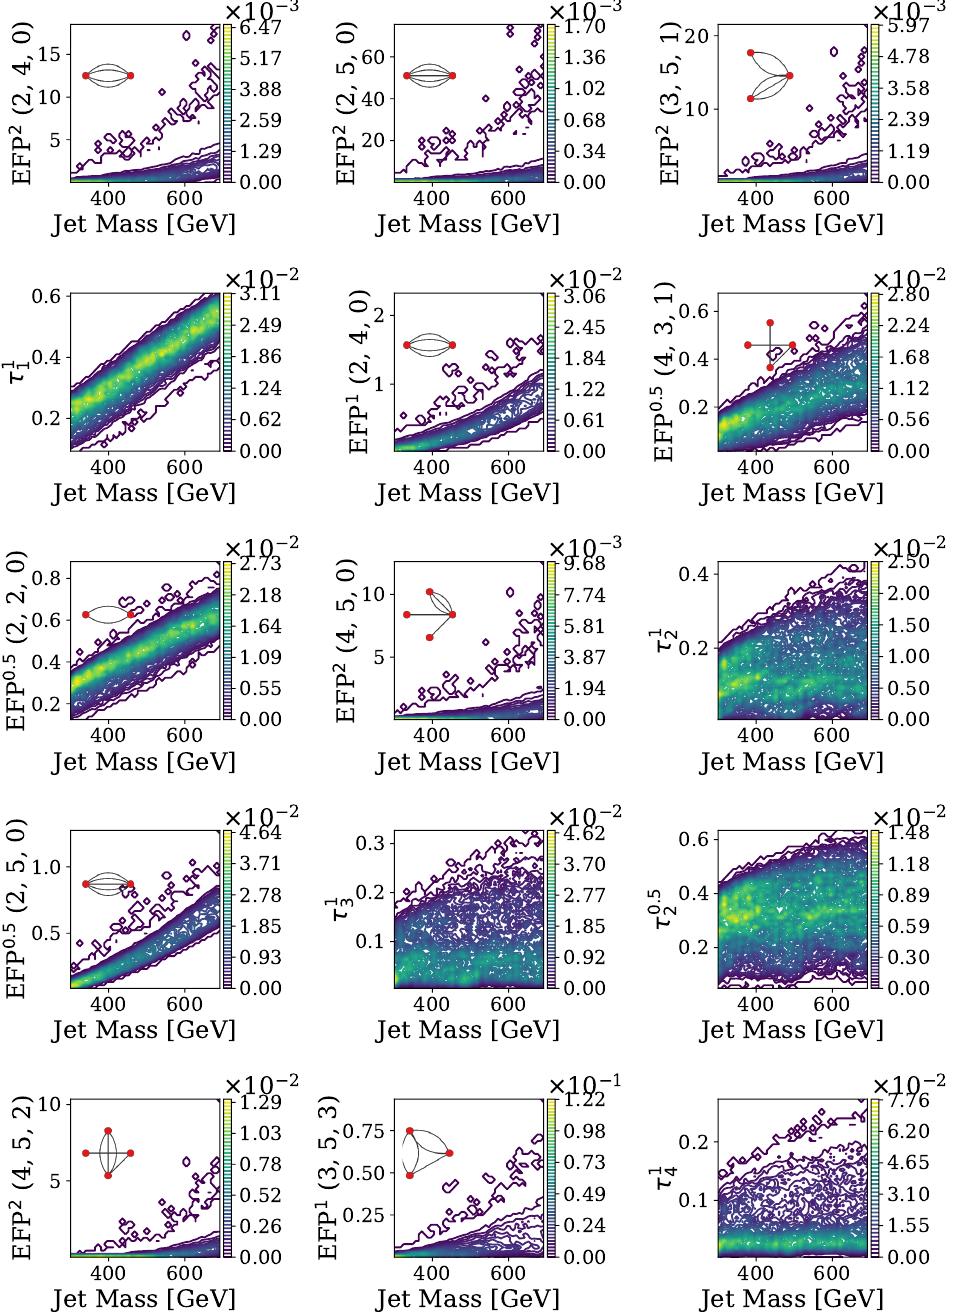
Figure 13 . Contour plots showing the probability density of the first half of the most important LASSO-selected observables versus the jet mass. The plots are ranked in order of importance, excluding the normalized jet mass, which ranks at number 12 and is omitted for brevity. The contour plots of the rest of the LASSO-selected observables are shown in figure